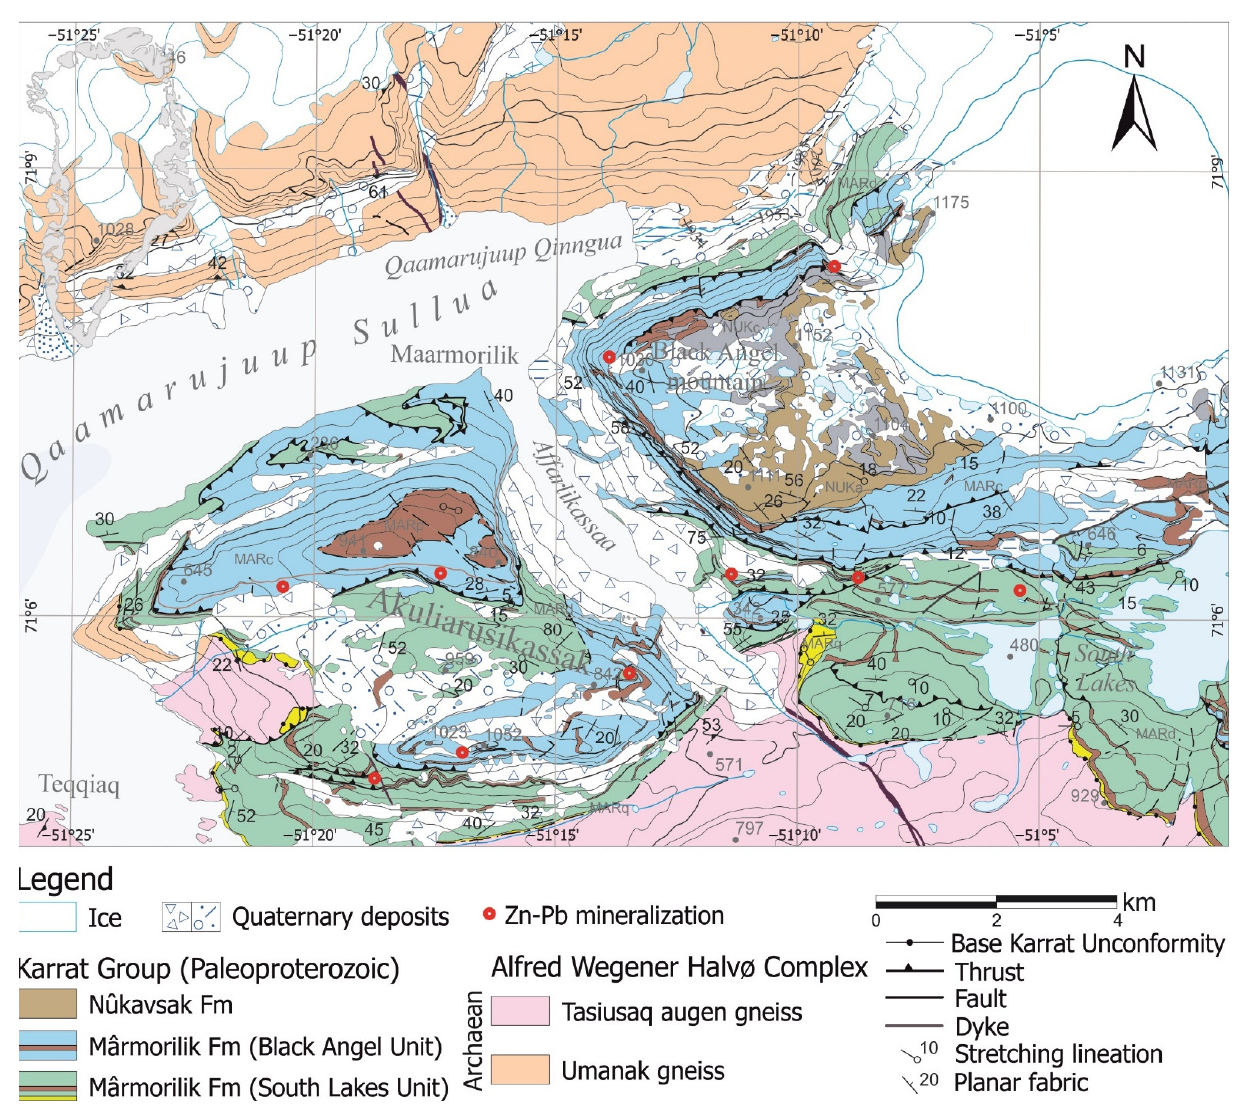
Figure 2. Geological map of Maarmorilik (modified after [8]). See location of the area in Figure